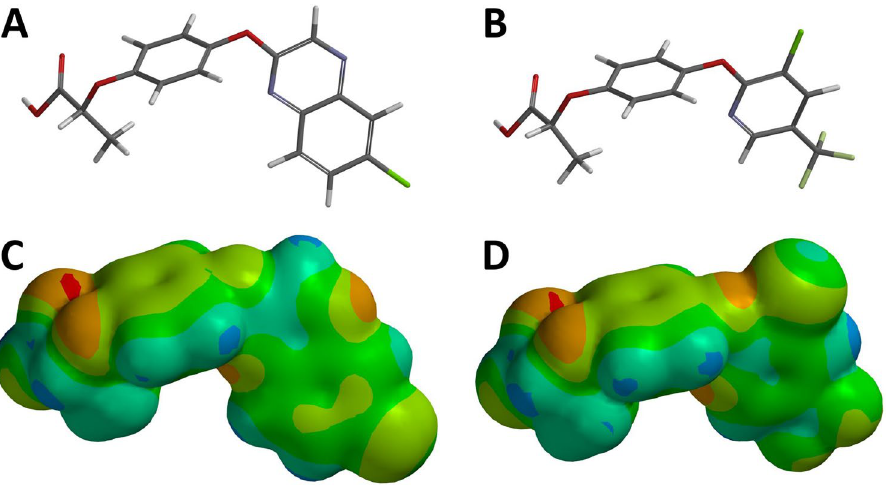
Figure 4. Structures of ( A ) quizalofop and ( B ) haloxyfop showing the carbons in gray, hydrogen in white, oxygen in red, nitrogen in blue, chlorine in green and fluorine in cyan on the left side. Electrostatic potential maps of ( C ) quizalofop and ( D ) haloxyfop. Colors on the volume represent range from electronegative (red) to electropositive (blue) partial charges. Images were generated using Spartan’20 version 1.1.2 (Wavefunction, Inc., Irvine, CA 92612) (https:// www. wavef un. com/).